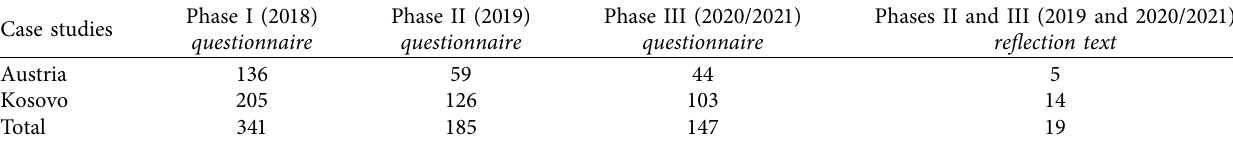
Table 1: Sample characteristics of student-teachers in Austria and Kosovo.